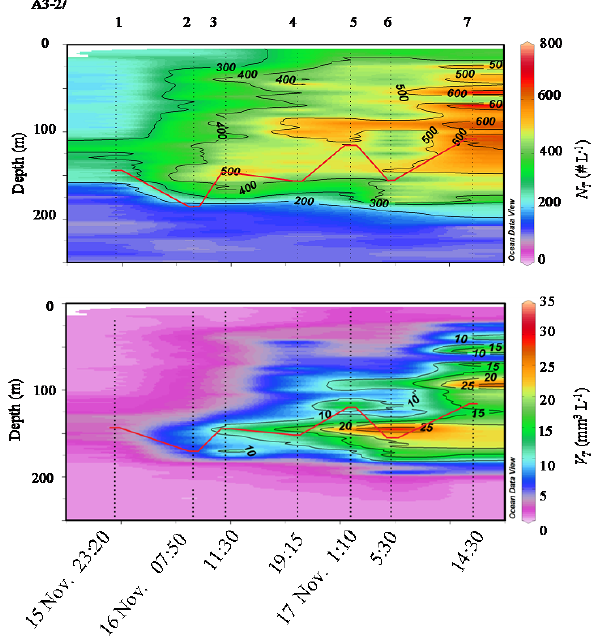
Figure 4. Vertical distribution of N T and V T for the different casts during early bloom